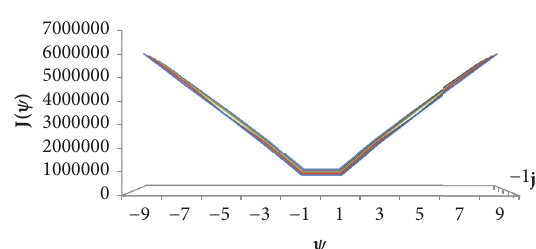
Figure10:Graphofexpectedpresentvalueoftheutilityofasset 𝐽(𝜓) versus control 𝜓 and tax ratio 𝑗 while subjective discount rate 𝜂 and degree of relative risk 𝜆 are fixed at 0.1 and 0.9 , respectively.